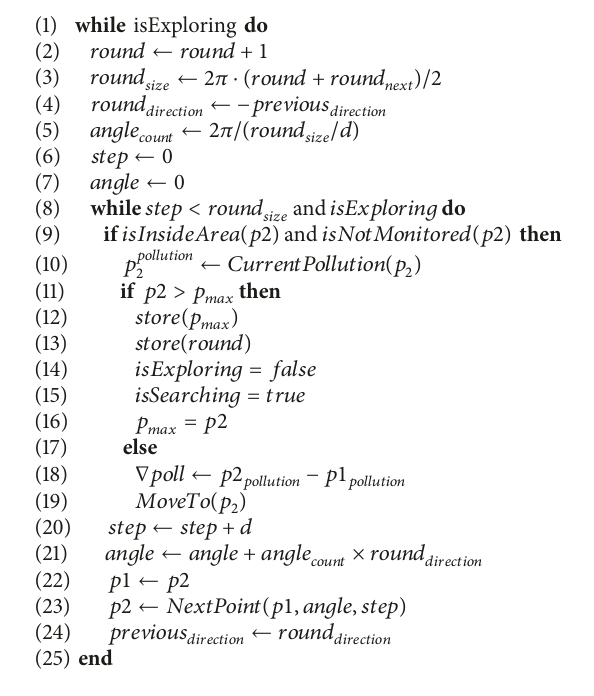
Algorithm 2: PdUC exploration phase.